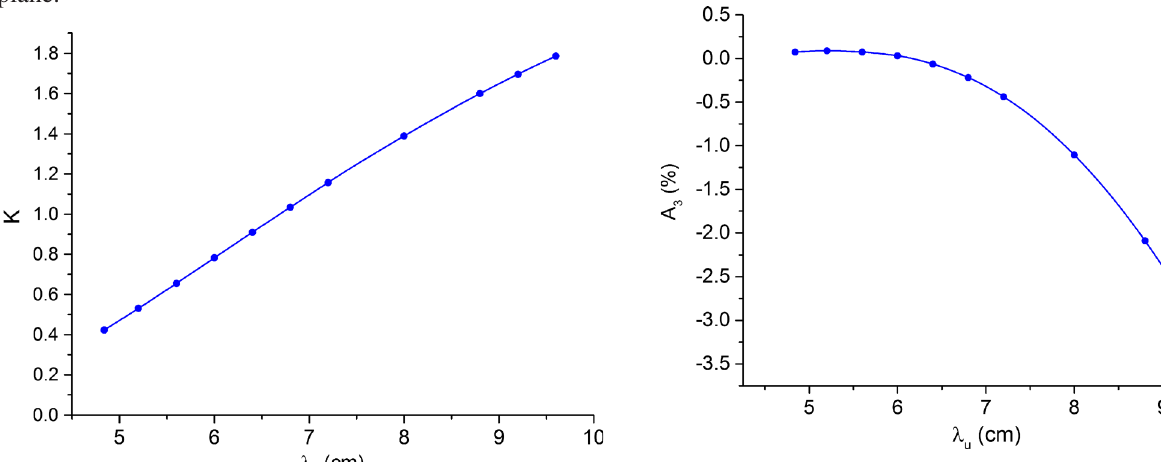
FIG. 7. Undulator deflection parameter.